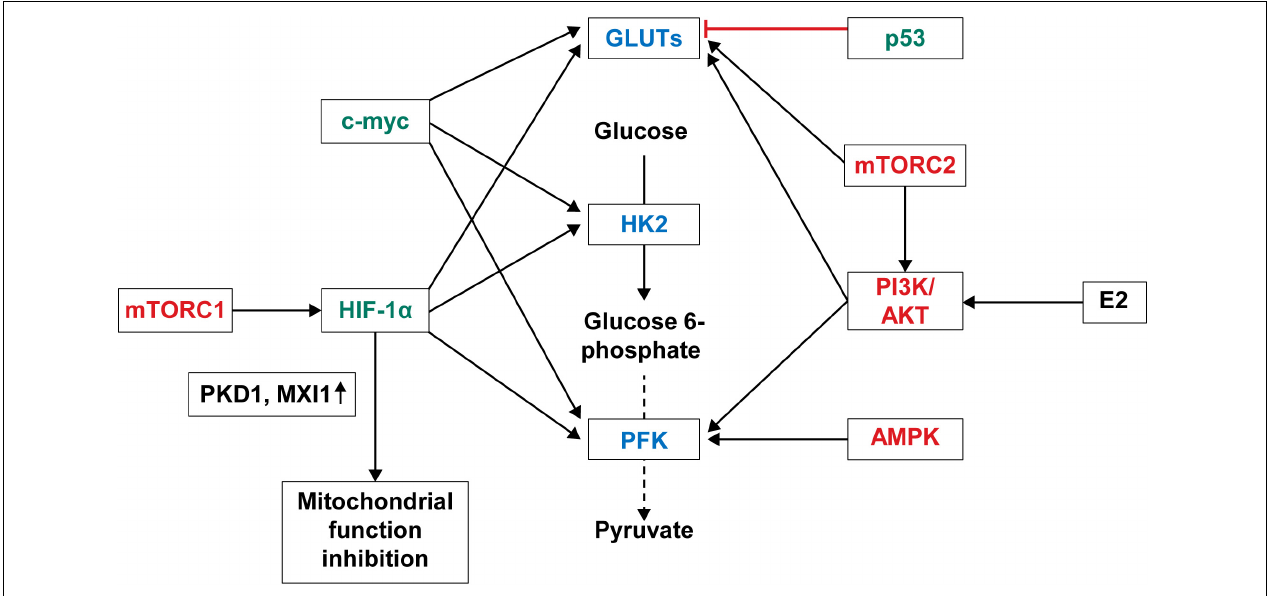
FIGURE 2 | Regulation of glycolysis and glucose transporters in breast cancer. Important signaling pathways regulating glycolysis and glucose transporters in breast cancer are the PI3K/AKT, AMPK, and mTOR pathways. PI3K/AKT pathway activated by 17-estradiol (E2) or genetic mutations increases expression of PFK2 and GLUT. AMPK pathway activated in breast cancer transports GLUT4 to cell membrane through activation of PFK-2 and increases GLUT expression. mTORC1 among the mTOR complex increases the expression of PFK by activating HIF-1 α . mTORC2 either activates AKT or increases GLUT1 expression. Transcription factors regulating glucose metabolism in breast cancer are c-myc, p53, and HIF-1 α . As such, breast cancer with p53 mutation shows increased expression of GLUT because c-myc induces increased expression of GLUT, HK, and PFK, and p53 suppresses expression of GLUT. Lastly, activated HIF-1 α increases expressions of HK, PFK, LDHA, and GLUT, and suppresses mitochondrial function by activating PKD1 and MXII. PI3K, phosphoinositide 3-kinase; AKT, Ak strain transforming protein kinase B; AMPK, AMP-activated protein kinase; mTOR, mechanistic target of rapamycins; PFK, phosphofructokinase; HIF, hypoxia-inducible factor; HK, hexokinase; LDHA, lactate dehydrogenase A; PKD1, pyruvate dehydrogenase kinase 1; MXI1, MAX interactor